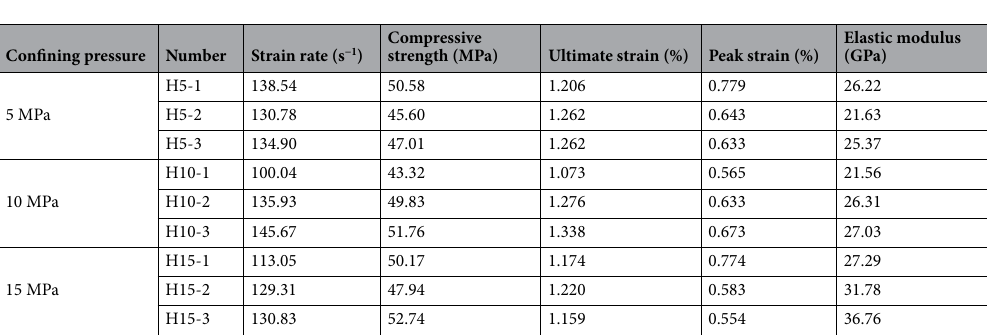
Table 6. Dynamic parameters of combined bodies with confining pressure under higher strain rate.